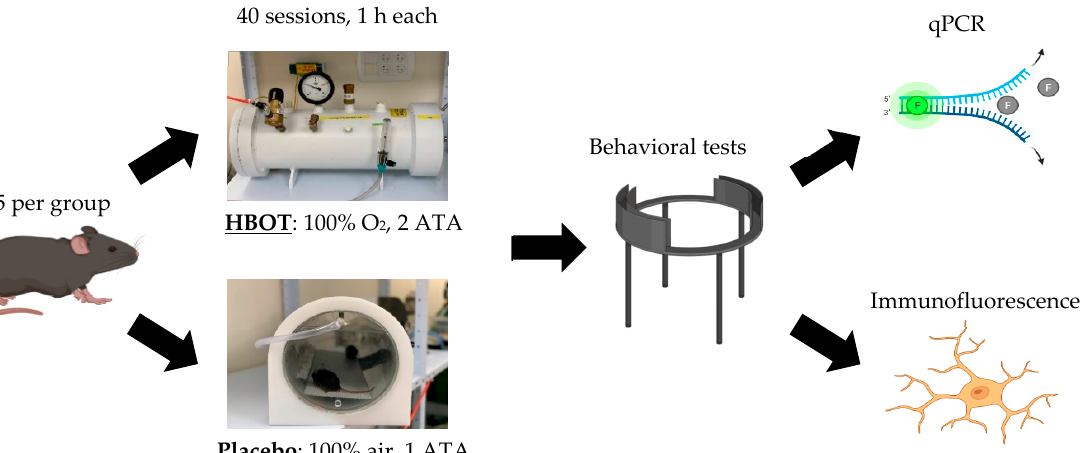
Figure 1. Graphical description of experimental procedures. InsG3680 (+/+) and littermates control mice were divided into two groups, HBOT and placebo. After two months of treatment, mice were tested in various behavioral tests, and afterward, InsG3680 (+/+) mice were used for qPCR and immunofluorescence analysis.